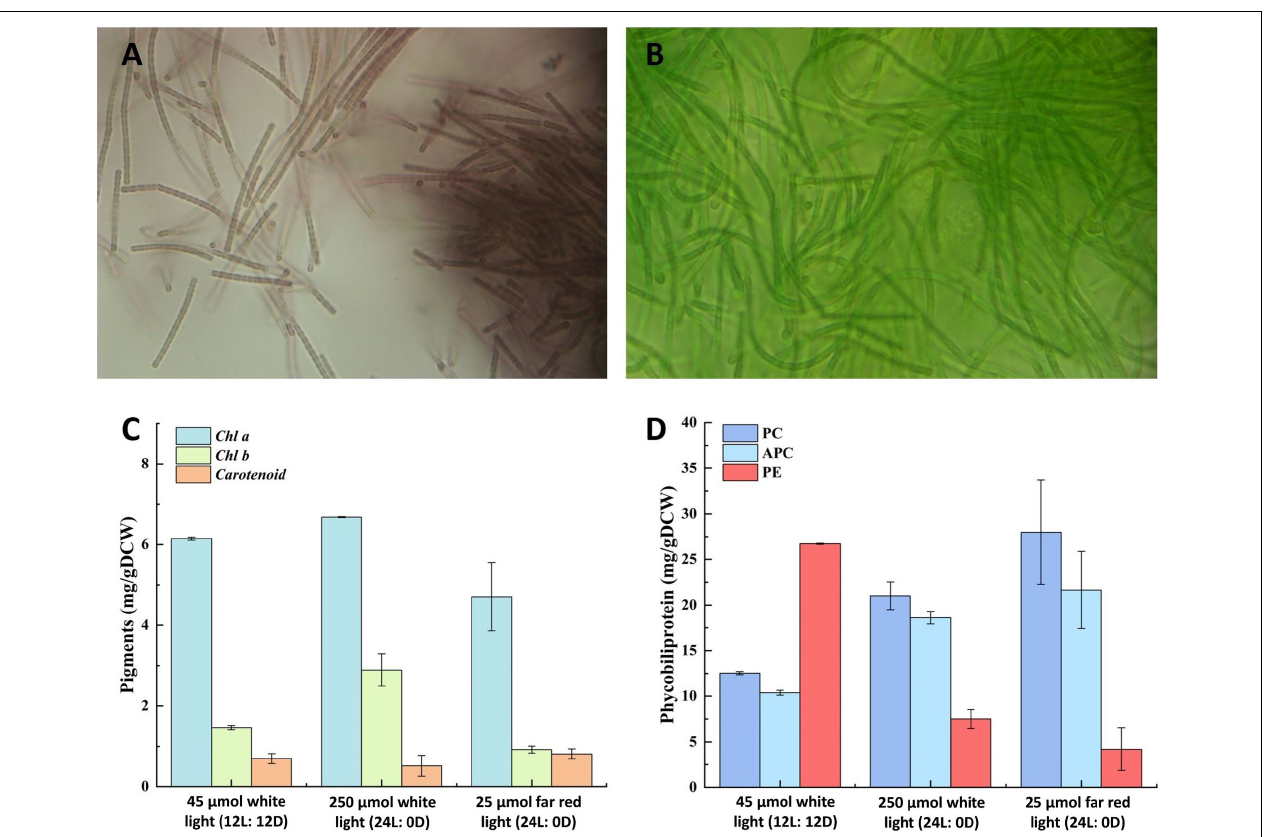
FIGURE 5 | Chromatic adaptation of strain E412. (A) Light microscopy image (1,000 × ) of strain E412 grown in white fluorescent light, 12L: 12D photoperiod at 45 µ mol m − 2 s − 1 , (B) light microscopy image (1,000 × ) of strain E412 grown in far-red (730 nm) LED light, 24L: 0D photoperiod at 25 µ mol m − 2 s − 1 , (C) composition of photosynthetic lipophilic pigments of strain E412 grown at different illumination conditions, the figure represents a mean of three biological replicates, (D) composition of photosynthetic water-soluble pigments of strain E412 grown at different illumination conditions, the figure represents a mean of three biological